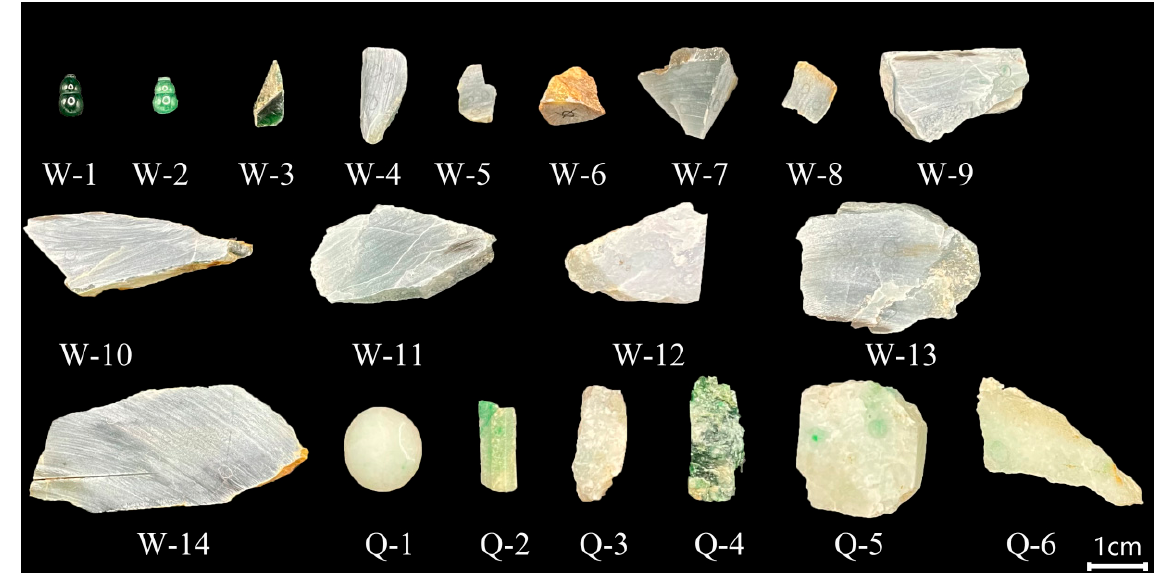
Figure 5. Guatemalan and Qing dynasty jadeite samples. (W-1 and W-2: cut thinly, use water transfer process, and show obvious green with tin foil back cover; W-3: white leather corners (jade peel visible), the color is darker and has a large number of black inclusions; W-4: ice jadeite interface material. The structure is dense, the transparency is good, and there is white cotton; W-5: the skin is thin and evenly distributed, and the inner jade flesh is delicate in texture and relatively high in transparency; W-6: the surface is infected with yellow and the structure is loose; W-7: the water is good, there are many cracks, and the skin shell is an incomplete thin layer of white; W-8: porcelain land, the germ quality is poor, but the jade is still relatively delicate to the naked eye; W-9: contains veined green veins, with shear fissures and goose-like fissures; W-10: the cortex is thin, and there are fine veins of red limonite on the surface of the rough, which are flush to the rough along the cracks; W-11: contains fine vein-like green veins, and the water is excellent; W-12: there are red limonite fine vein fractures on the surface, no skin shell, and the surface is evacuated; W-13: rough or standing to the touch, the fog under the skin shell (semi-weathered jadeite layer) is thin, white mist, dense in texture, green pine flowers on the epidermis, and finely veined green inside; W-14: there is a black–green–yellow–gray–blue color transition, and white cotton is visible in the gray–blue part. Q-1: contains small fine veins of green, with presence of a fly wing phenomenon; Q-2: the whole is green, the fly wing phenomenon is present, and there are cracks on the surface; Q-3: There is a small green vein on the surface and cracks on the surface; Q-4: the color is darker, there are cracks on the surface, and there are black inclusions; Q-5: contains green veins, there are many cracks on the surface, the fly wing phenomenon is present; Q-6: the surface has green veins, brown substance, and the fly wing phenomenon is obvious.)